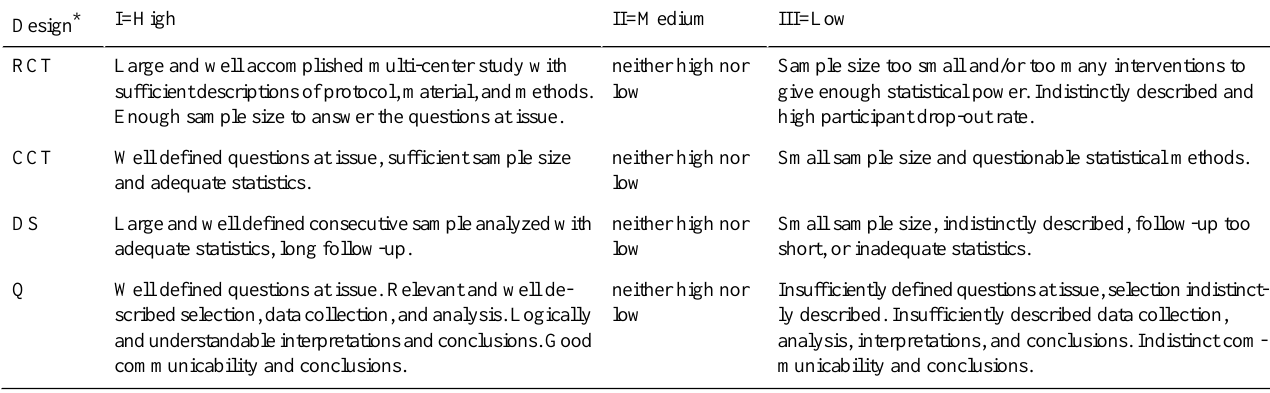
Table 2. Criteria for quality assessment, based on the criteria for quality assessment from the Swedish Council on Technology Assessment in Health Care (SBU)